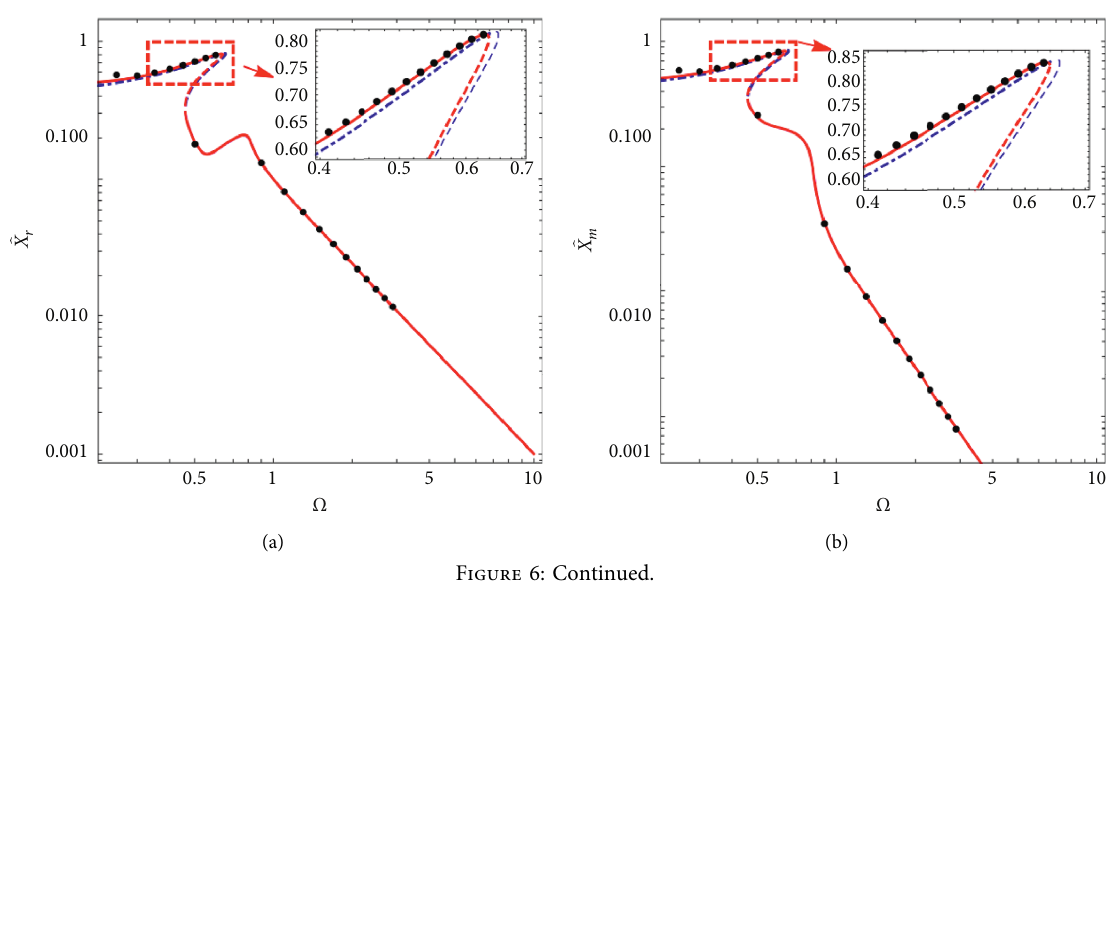
Figure 5: Amplitude-frequency curves of m and (a) 􏽢 F e � 0 . 01, (b) 􏽢 F e � 0 . 1, (c) 􏽢 F e � 1, and (d) 􏽢 F e � 10, respectively. Dashed-dotted line , stable solution by the HBM1; thin-dashed line , unstable solution by the HBM1; solid line , stable solution by the EHBM; thick-dashed line , unstable solution by the EHBM; dot , numerical